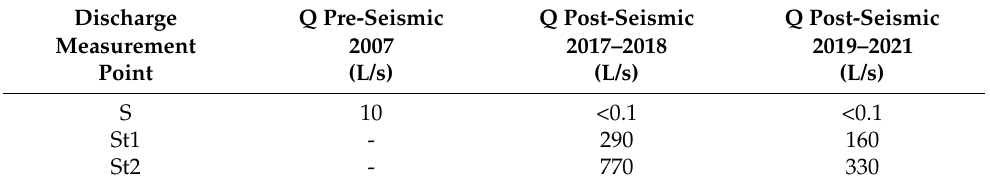
Figure 3. Discharge trends of St1, St2, Sordo stream and Torbidone Spring measurement sections. Daily rainfall data of Norcia station are reported. The main shocks of 24 August 2016 and 30 October 2016 are indicated with red vertical lines. The blue dashed line tagged with the question mark represents the engineering judgment of the St1 discharge curve for the period October 2016–May 2017. Table 1. Discharge variation due to the seismic sequence in three discharge measurement points along Campiano